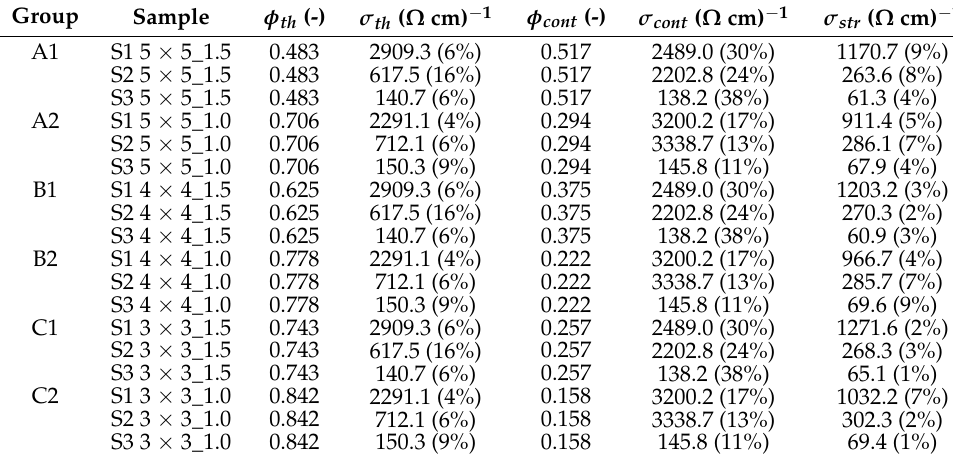
Table 5. Characterisation of woven structures and their components.